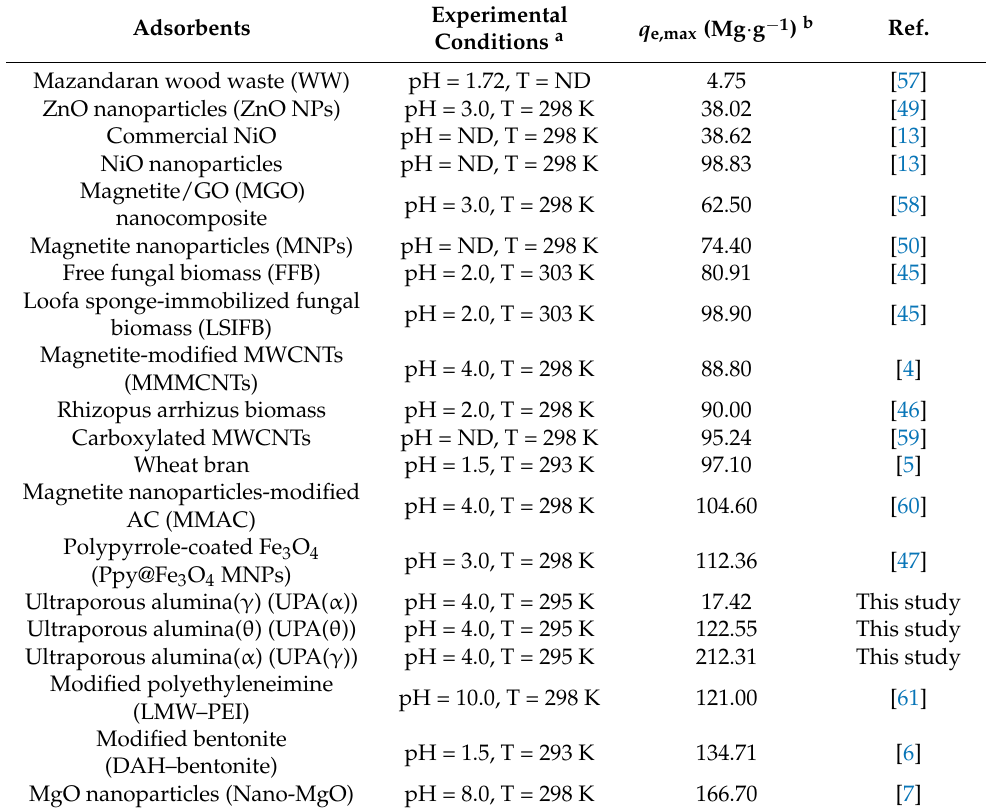
Table 5. Comparison of RBBR adsorption capacity retained by UPA materials with other organic, inorganic, or bio-based adsorbents reported in related studies in the literature. Adsorbents